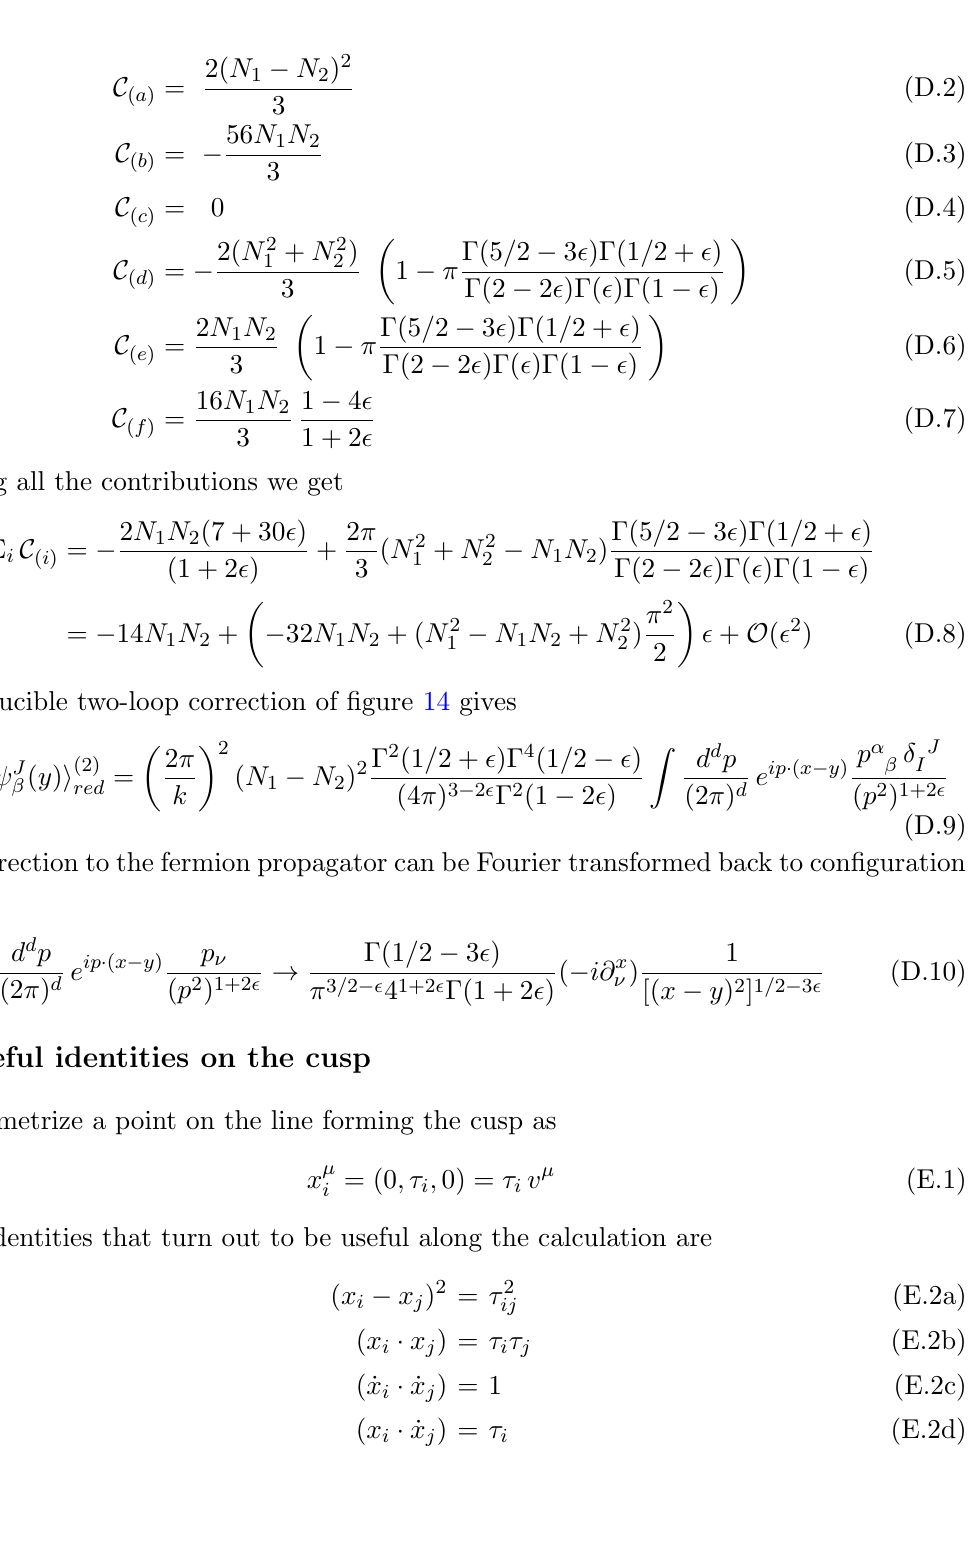
Figure 14 . Reducible contribution to the two-loop fermion